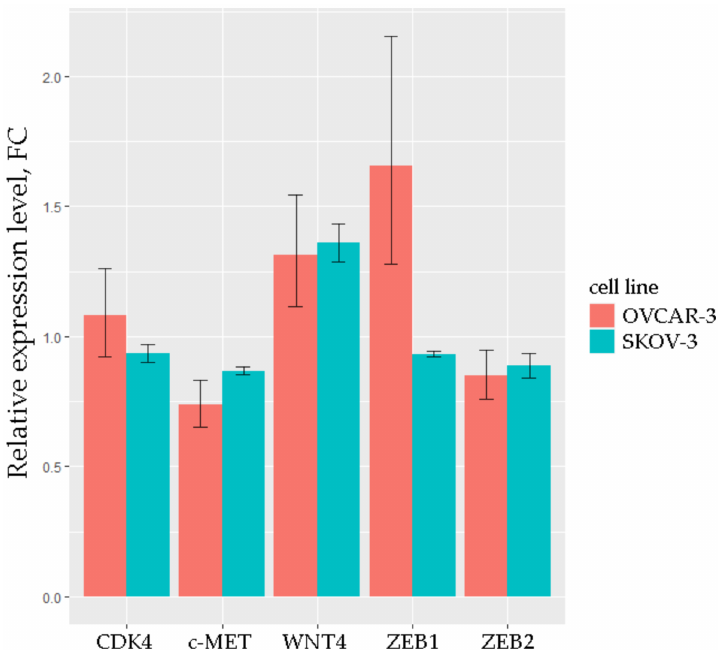
Figure 6. Relative expression levels of 5 mRNAs in OVCAR-3 and SKOV-3 cell lines transfected with the miR-203a mimic. p .adj < 0.05 for each mRNA, the results are based on three technical